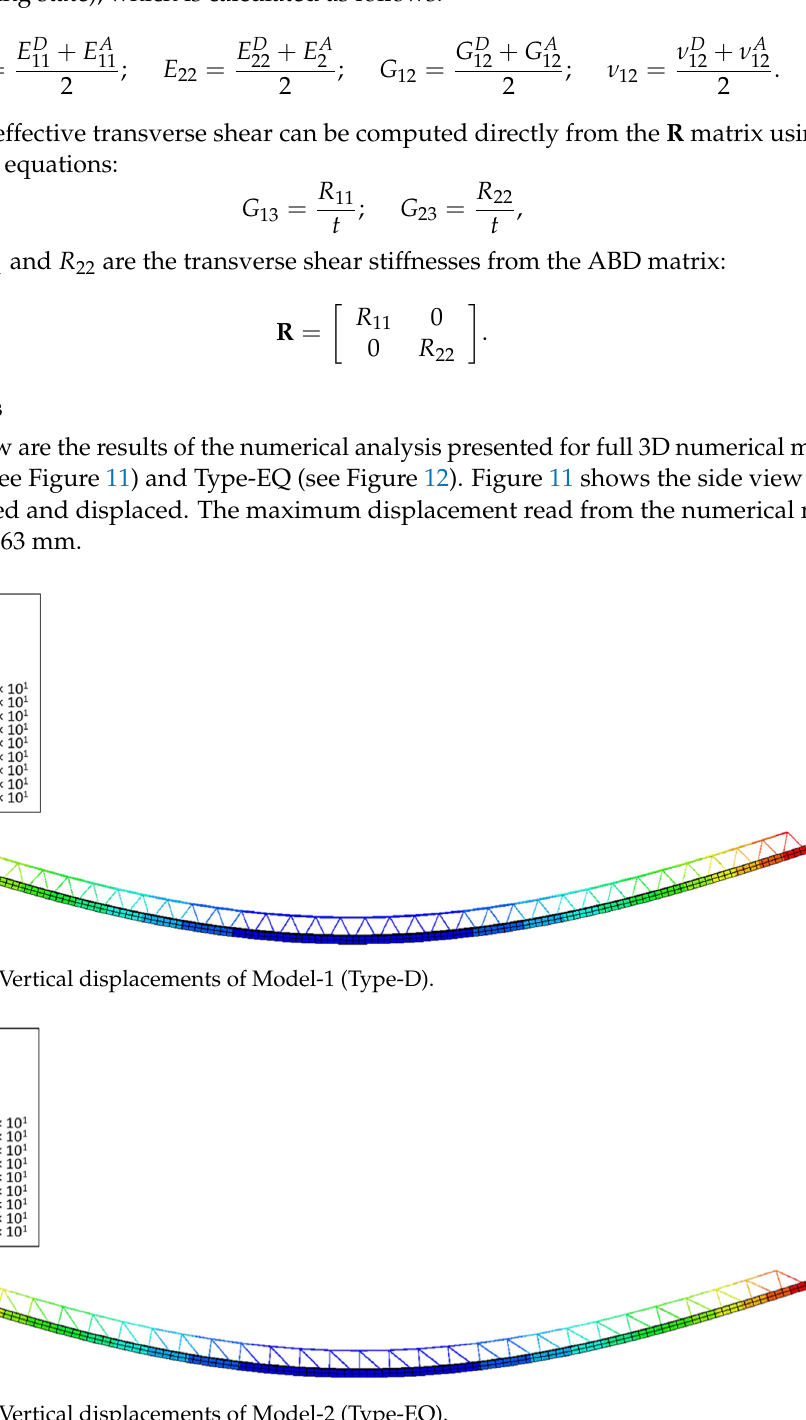
Figure 12. Vertical displacements of Model-2 (Type-EQ).